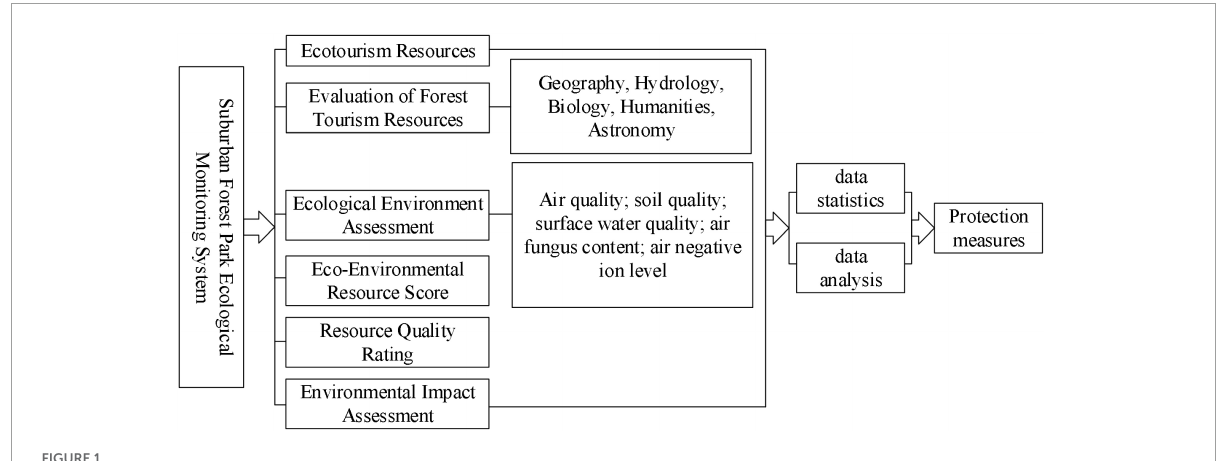
FIGURE1 Ecological environment monitoring system